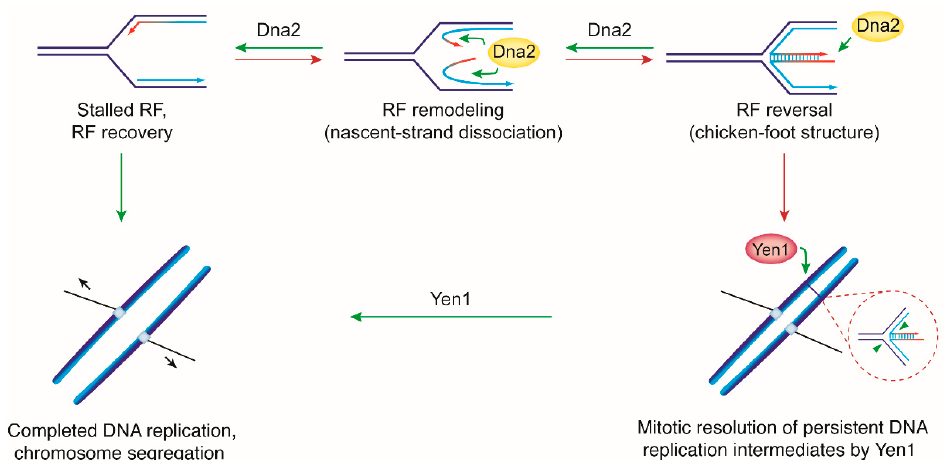
Figure 3. Model for a conserved role of Dna2 DNA2 in replication fork (RF) recovery. Stalled RFs may be able to resume DNA synthesis and/or remain in a configuration conducive to passive rescue by fusion with an oncoming, active RF. Alternatively, RF remodeling can occur, which requires dissociation of the nascent leading and lagging strands. If the dissociated nascent strands anneal, RF reversal results in a four-way chicken-foot structure. Dna2 has been implicated in the processing of dissociated single-strands and fully reversed RFs. Controlled nascent-strand degradation by Dna2 restores a canonical three-way RF architecture and promotes replication completion. Intermediates escaping the attention of Dna2 physically link sister chromatids at sites of underreplication and preclude chromosome segregation. Holliday junction resolvase Yen1 provides a fail-safe mechanism for the removal of persistent replication intermediates in mitosis. The interplay between DNA2 and the human Yen1-homolog GEN1 remains to be investigated. DNA intermediates colored red are non-productive in DNA replication and their processing (green arrows) is required for complete chromosome replication and proper chromosome segregation.